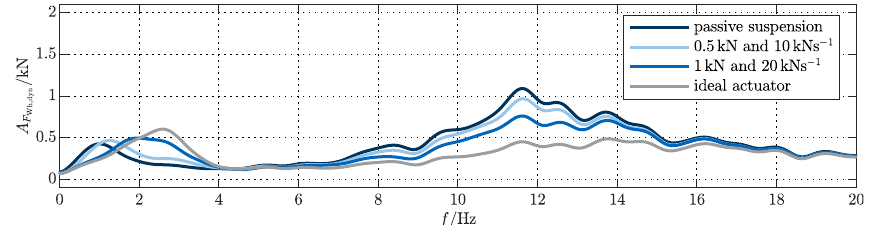
Figure A13. FFT of dynamic wheel-load for the BC profile at 90kmh − 1 with the objective of minimizing dynamic wheel-load